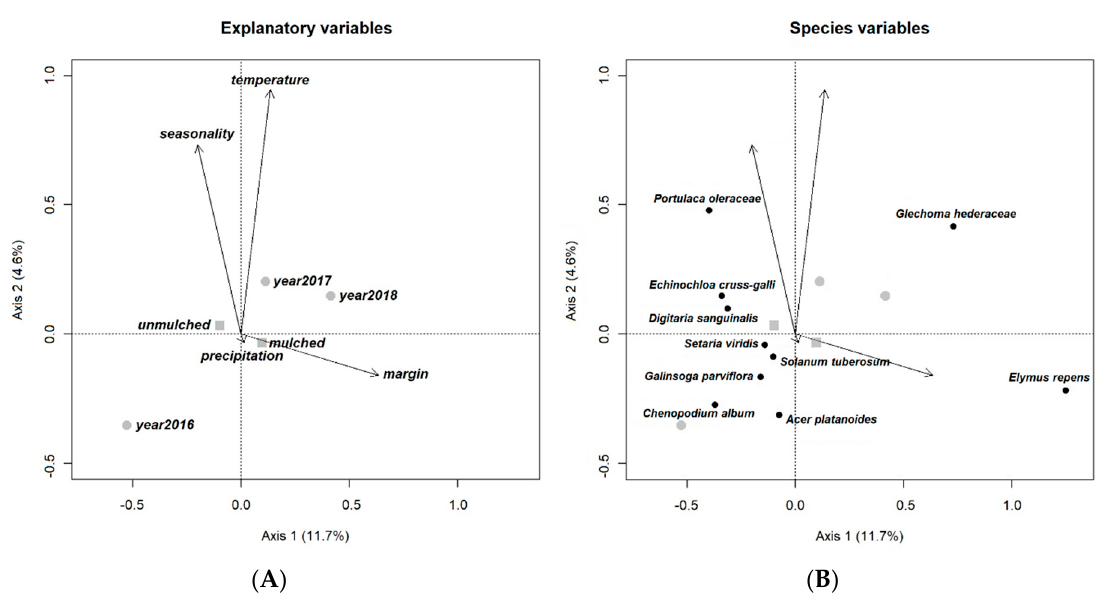
Figure 1. Ordination diagrams of the redundancy analysis (RDA) containing explanatory variables and the weed species to demonstrate connection within explanatory variables ( A ) and between explanatory variables and weed species ( B ) of open field tomato experiment (Gödöll ő , Hungary, 2016–2018). Only ten species with the highest weight on the first two RDA axes are presented. Circle = year; square = mulching.